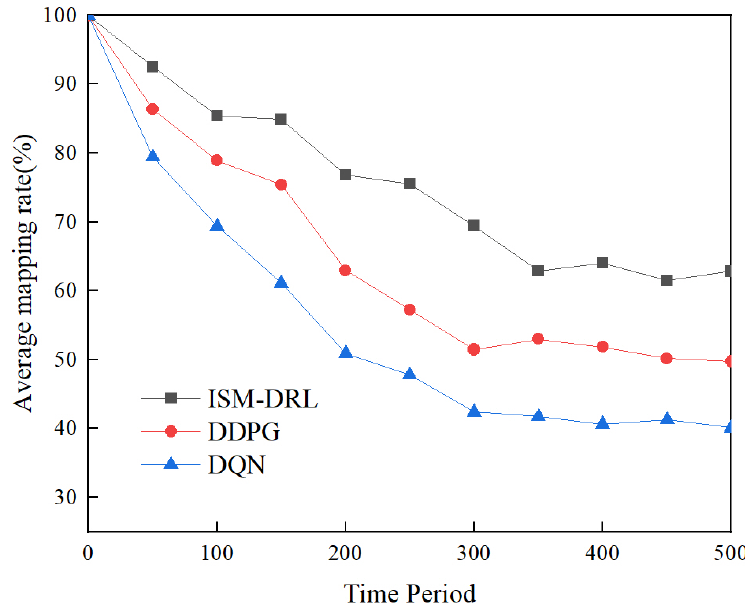
Figure 7. Average mapping rate at α 1 = 0.5, α 2 =